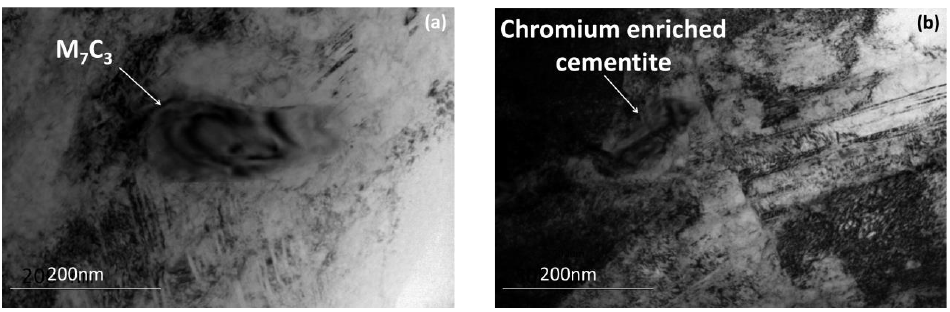
Figure 7. TEM micrograph of microstructure after UFHT ( a ) Chromium carbide M 7 C 3 in the microstructure after UFHT, ( b ) chromium-enriched cementite near grain boundaries.